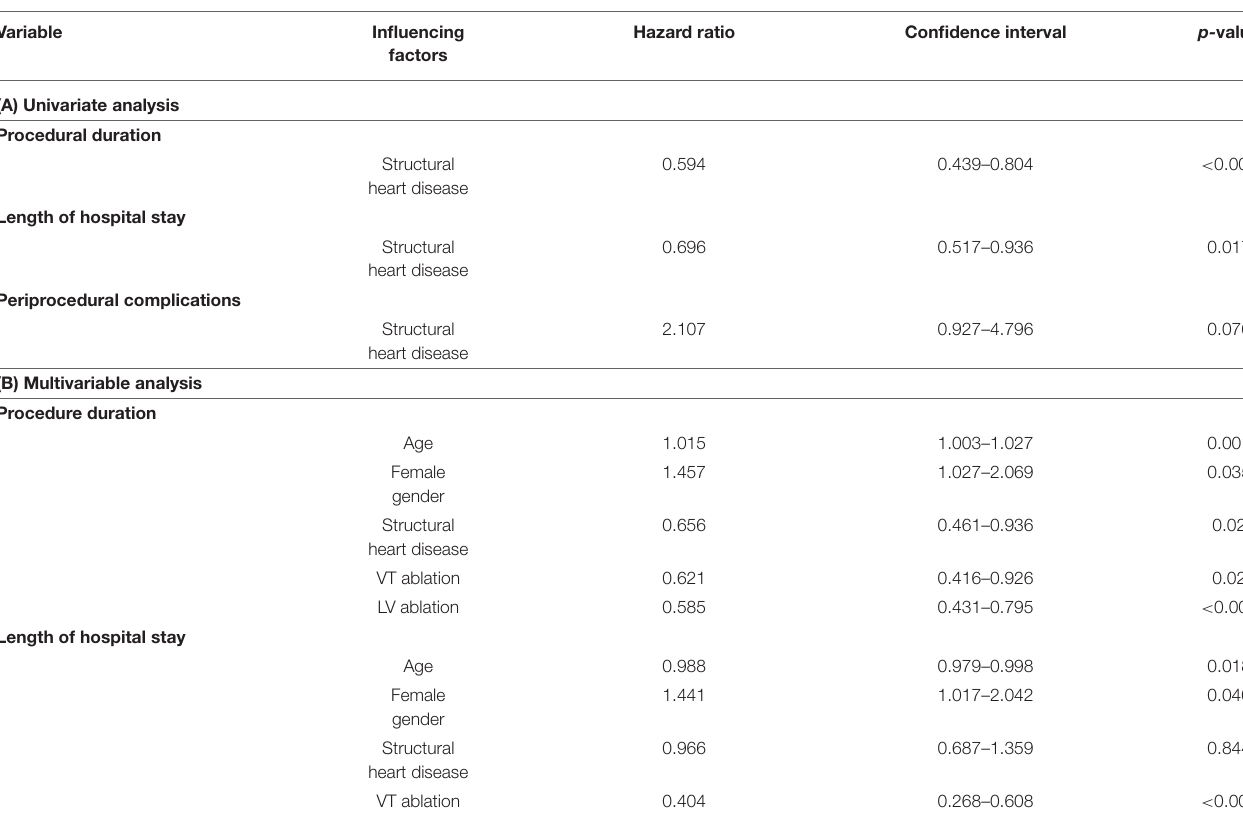
TABLE 4 | Uni- and multivariable